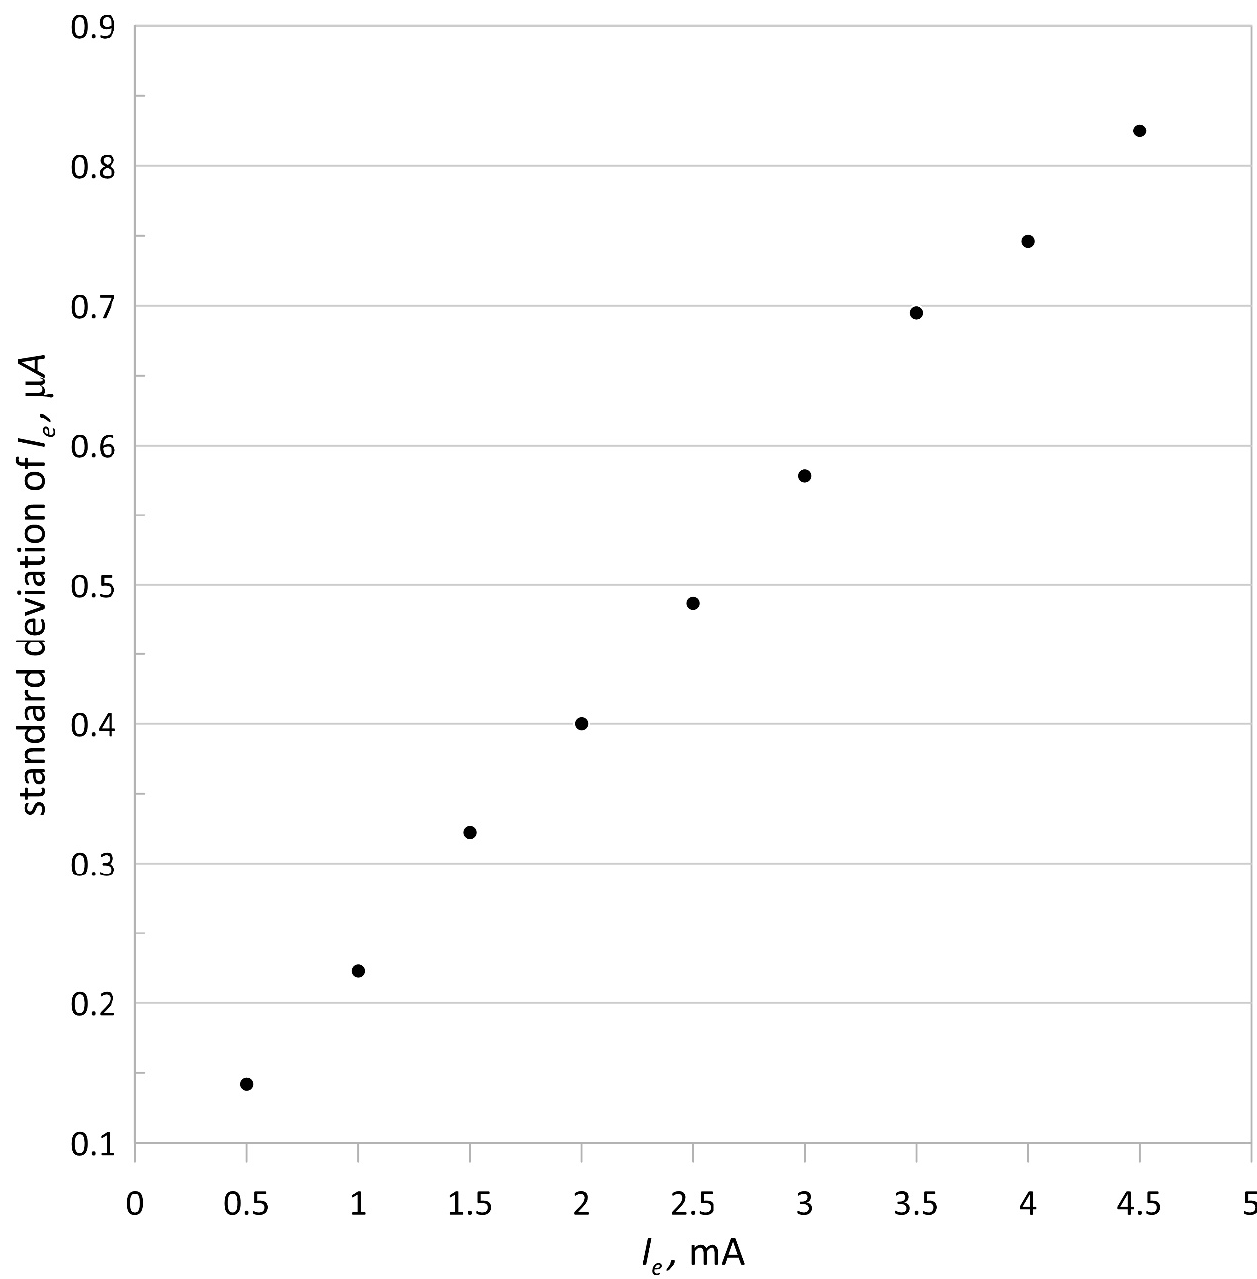
Figure 6. Standard deviation of the emission current versus its intensity; the accelerating voltage V = 100 V.